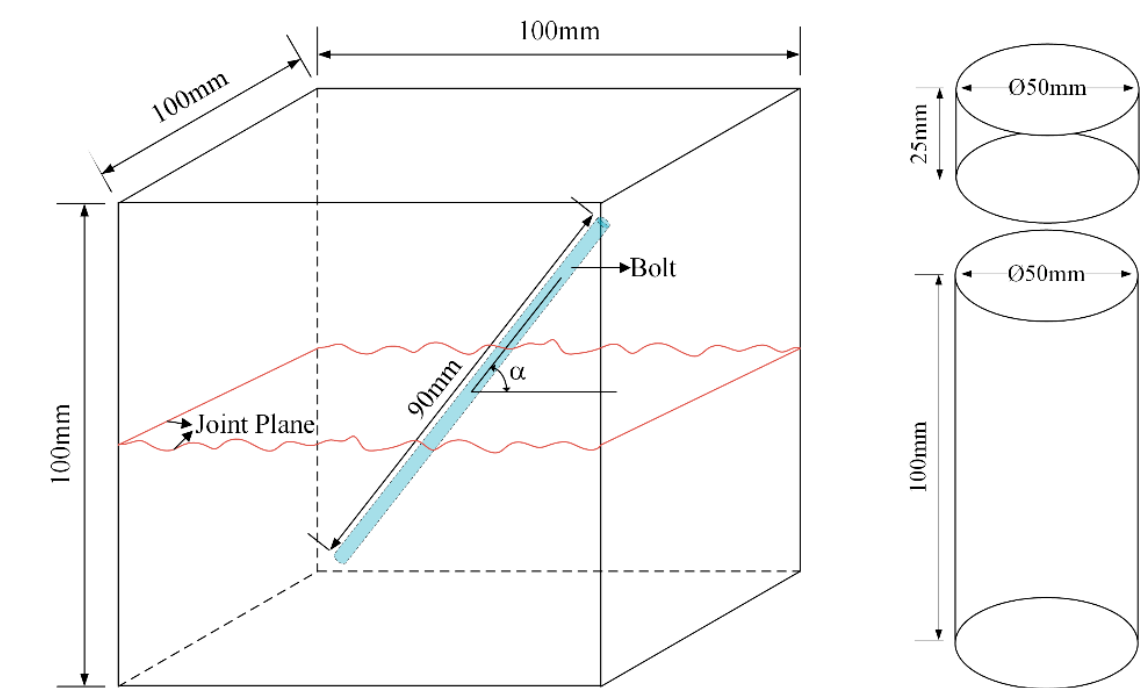
Figure 4. The diagrammatic sketch of specimens in this study.